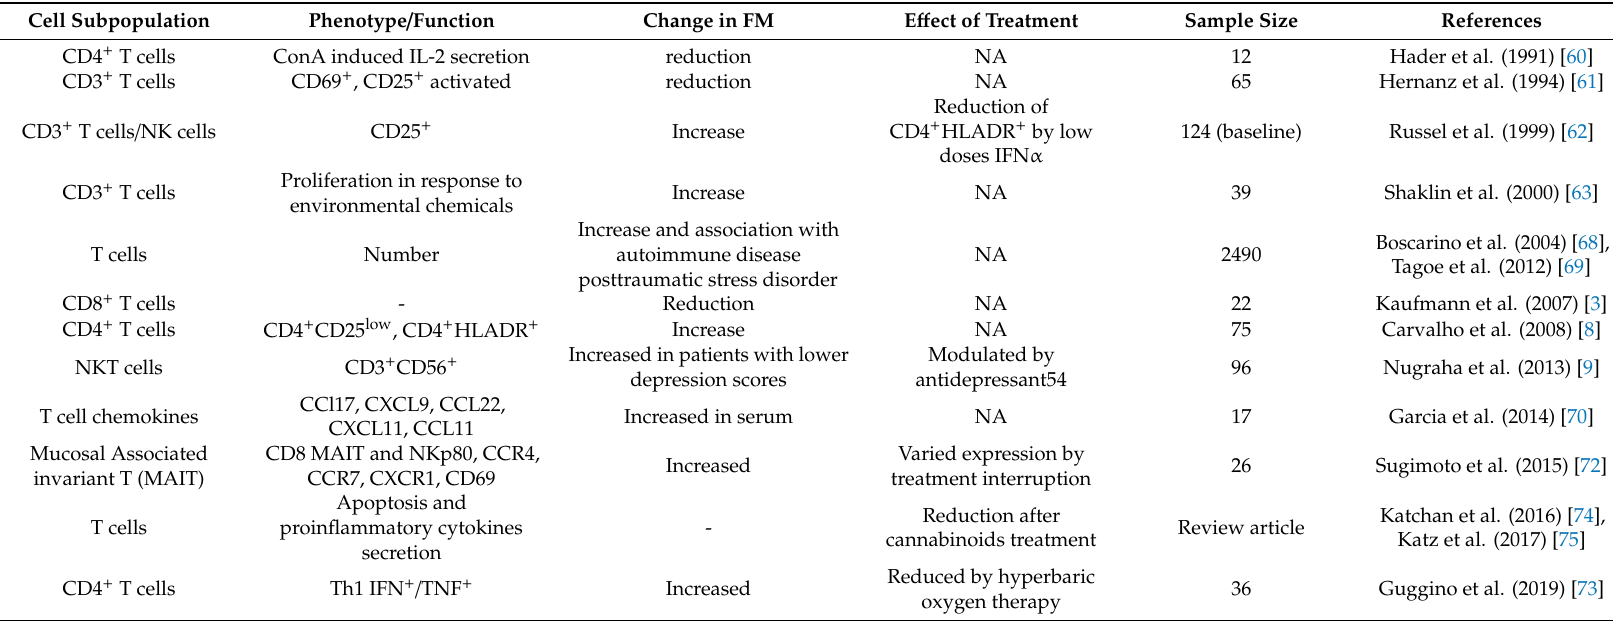
Table 1. Summary of literature data on T lymphocytes and